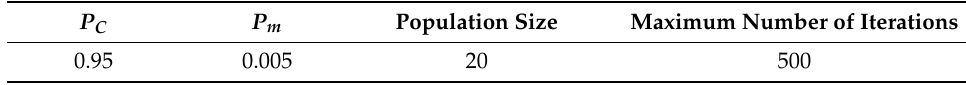
Table 2. Parameter settings of genetic algorithm.